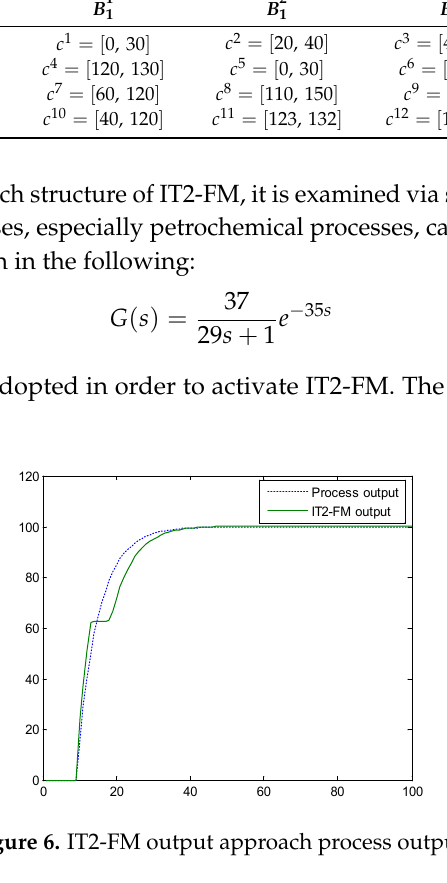
Figure 7. Open loop structure of the IT2-FM inverse controller. Since the IT2-FM has a stronger ability to deal with a dynamic process compared with T1-FM, the control performance of the inverse controller based on IT2-FM is superior to the corresponding type-1 counterpart. In Section 3, it has been verified that the approach structure of the IT2-FM is valid, i.e., y ( k ) = ref . Thus, if the IT2-FM approaches the process exactly, the process output would converge to the reference value. The structure of proposed inverse controller based on IT2-FM is shown in Figure 8, which provides an effective control performance [4,17,37].